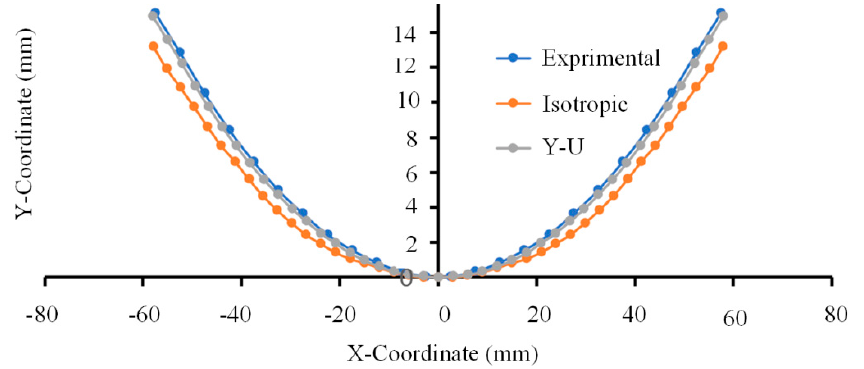
Figure 14. Comparison of the final shapes after springback between the experimental and simulation